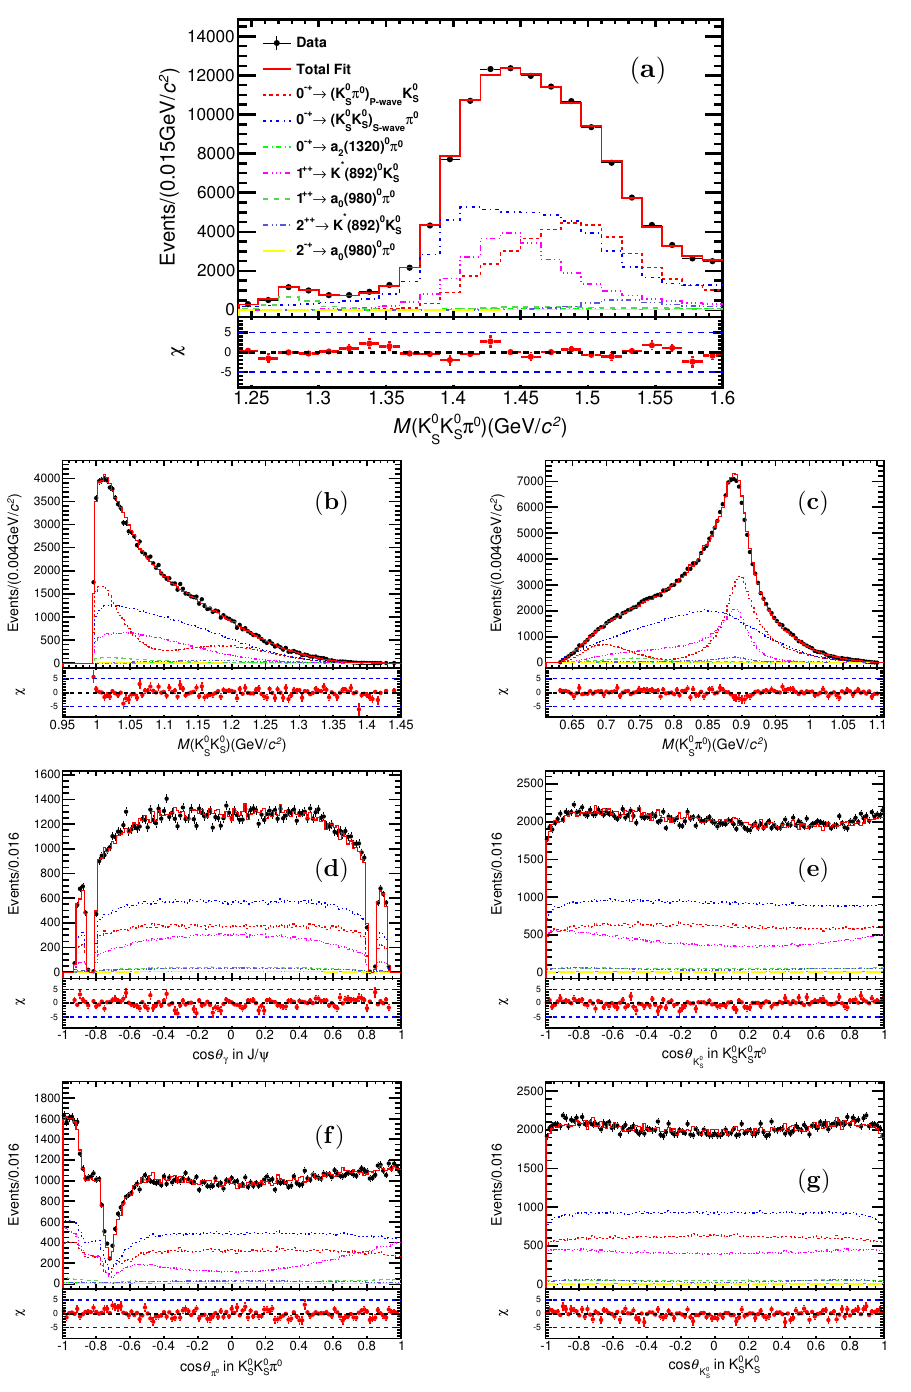
Figure 4 . Superposition of data and the MD PWA fit projections for invariant mass distributions of (a) K 0 , and (c) K 0 K 0 π 0 , (b) K 0 K 0 π 0 . The cos θ distributions of (d) γ in J/ψ helicity frame, S S S S S (e) K 0 and (f) π 0 in K 0 K 0 π 0 system helicity frame, (g) K 0 S S S pull projection of residual is shown beneath each distribution